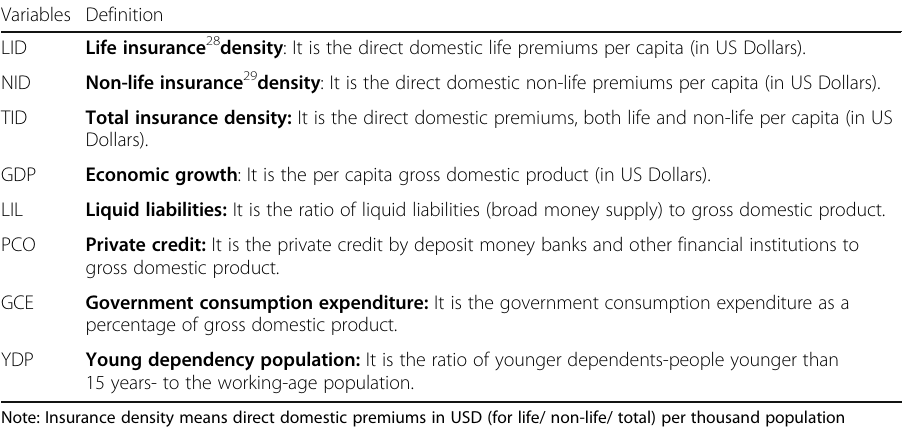
Table 9 Definition of Variables Relating to Insurance Markets and Economic Growth Variables